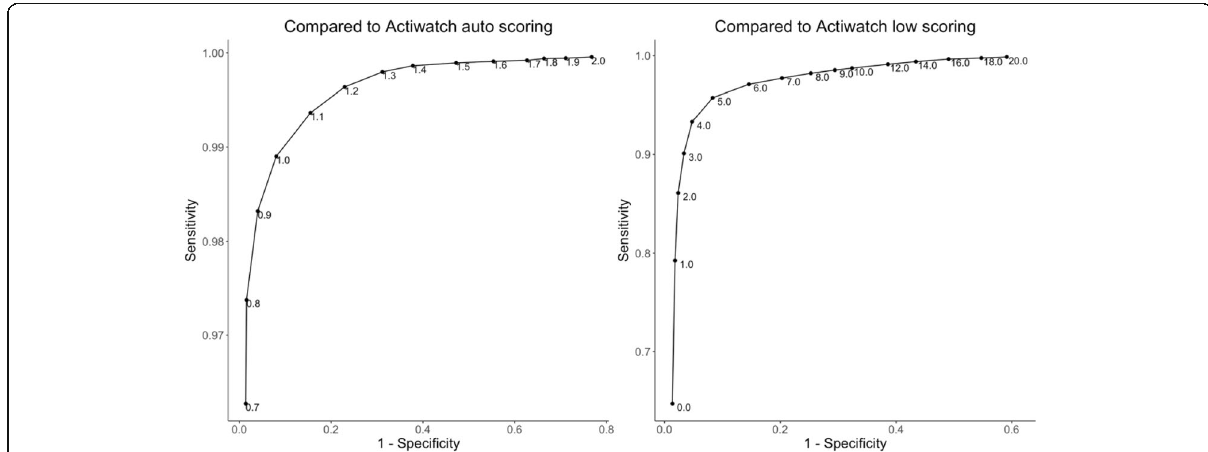
Fig. 3 (Left) A receiver operating characteristic (ROC) curve showing varying constant factors from 0.5 to 2.0 used in the Wake Threshold Value formula for Arc, as compared to results generated by the auto algorithm from the Actiwatch. (Right) A ROC curve showing varying Wake Threshold Values from 0 to 20, as compared to results generated by the low algorithm from the